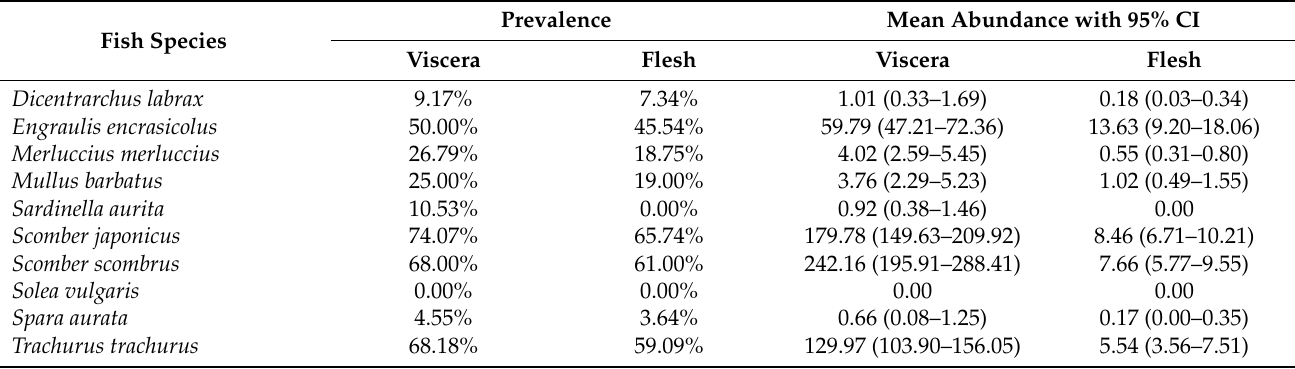
Table 2. Prevalence (%) and mean abundance with 95% confidence intervals (calculated using the bootstrap method) of anisakid L3 type I larvae in the fish species, analyzed with respect to the microhabitat of parasitation.